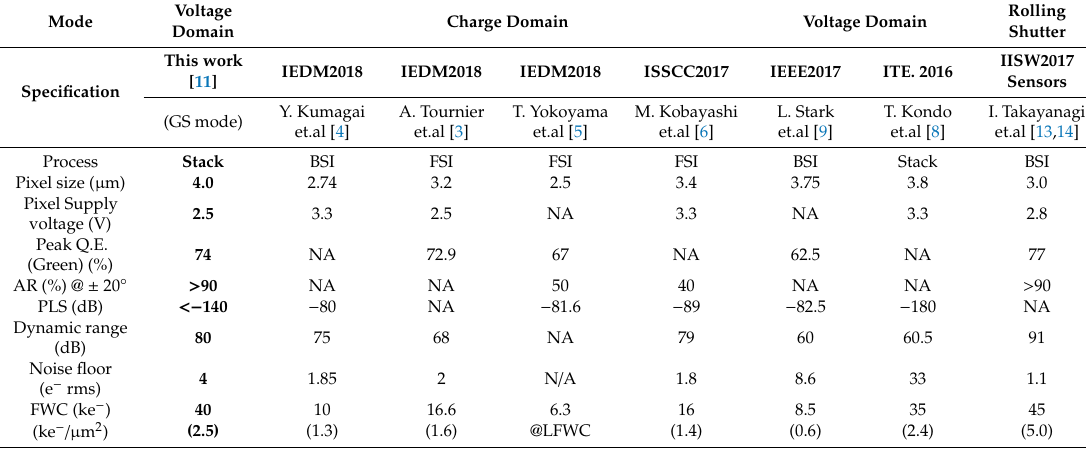
Table 3. Specifications and performance